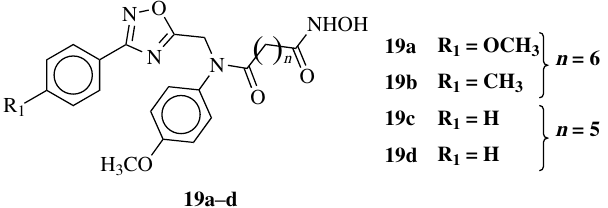
Figure 10. Chemical structures of hydroxamate-based